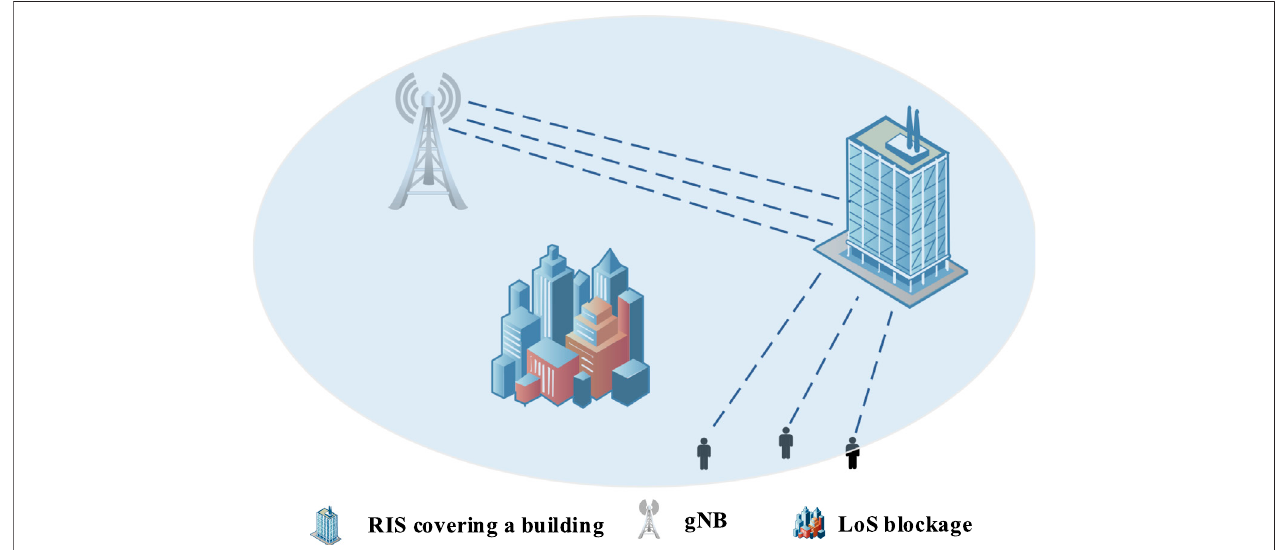
FIGURE 2 | The proposed EMF-aware cellular system design using a RIS for beyond 5G